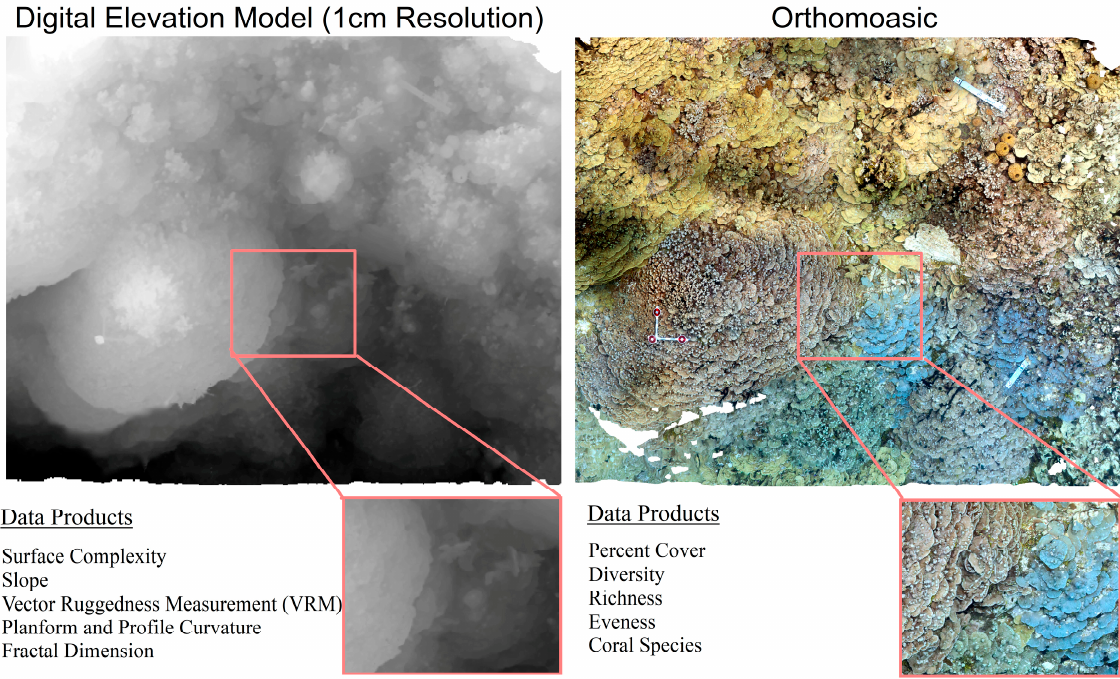
Figure 2. Examples of data products derived from 3D reconstructions of the benthic habitats in this study. Digital elevation models ( left ) are used to extract multiple metrics of 3D habitat complexity, and orthomosaics ( right ) are used for digital annotations to quantify coral assemblage structure.